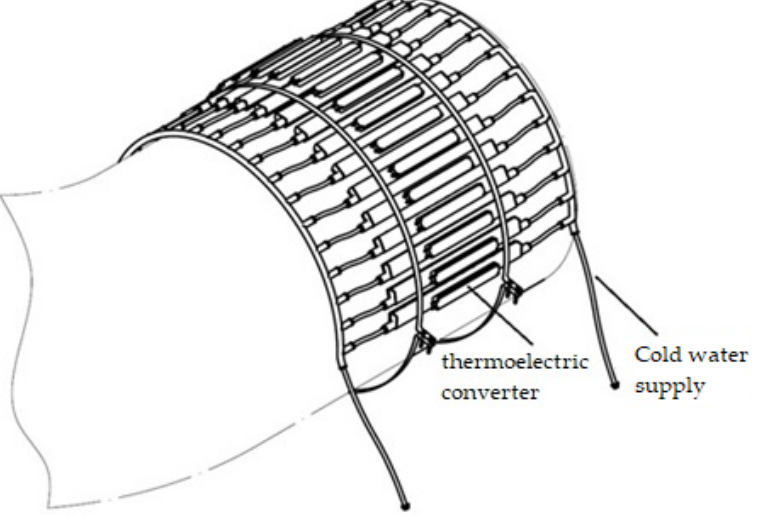
Figure 8. Layout option for a gas cooling system consisting of several thermoelectric converter modules. To mount a system of cooling modules, a perforated fastening tape is used, which is tightened with a bolted connection, as shown in Figure 9.